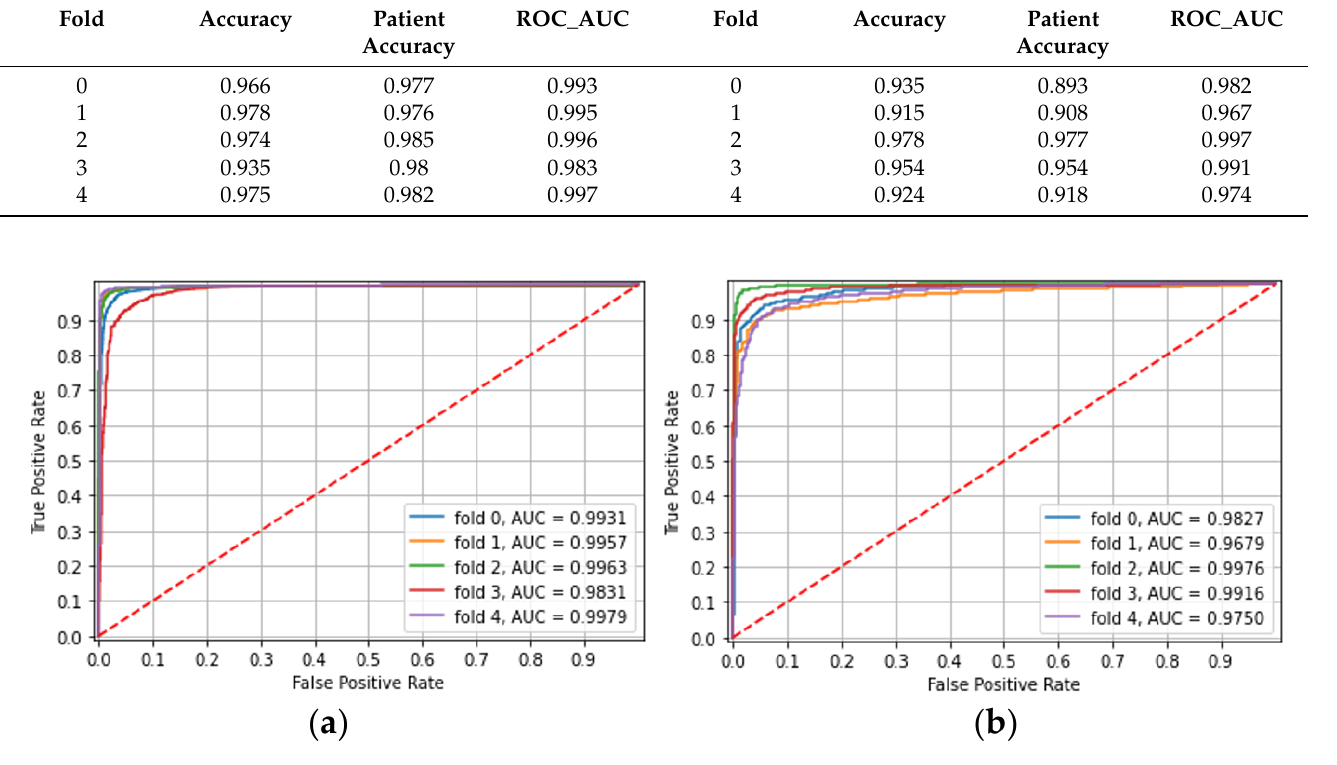
Figure 1. Experiment 1-Identification of small bowel ulcerated mucosa according to capsule type: ( a ) PillCam SB3 CE images, ( b ) PillCam Crohn CE images.